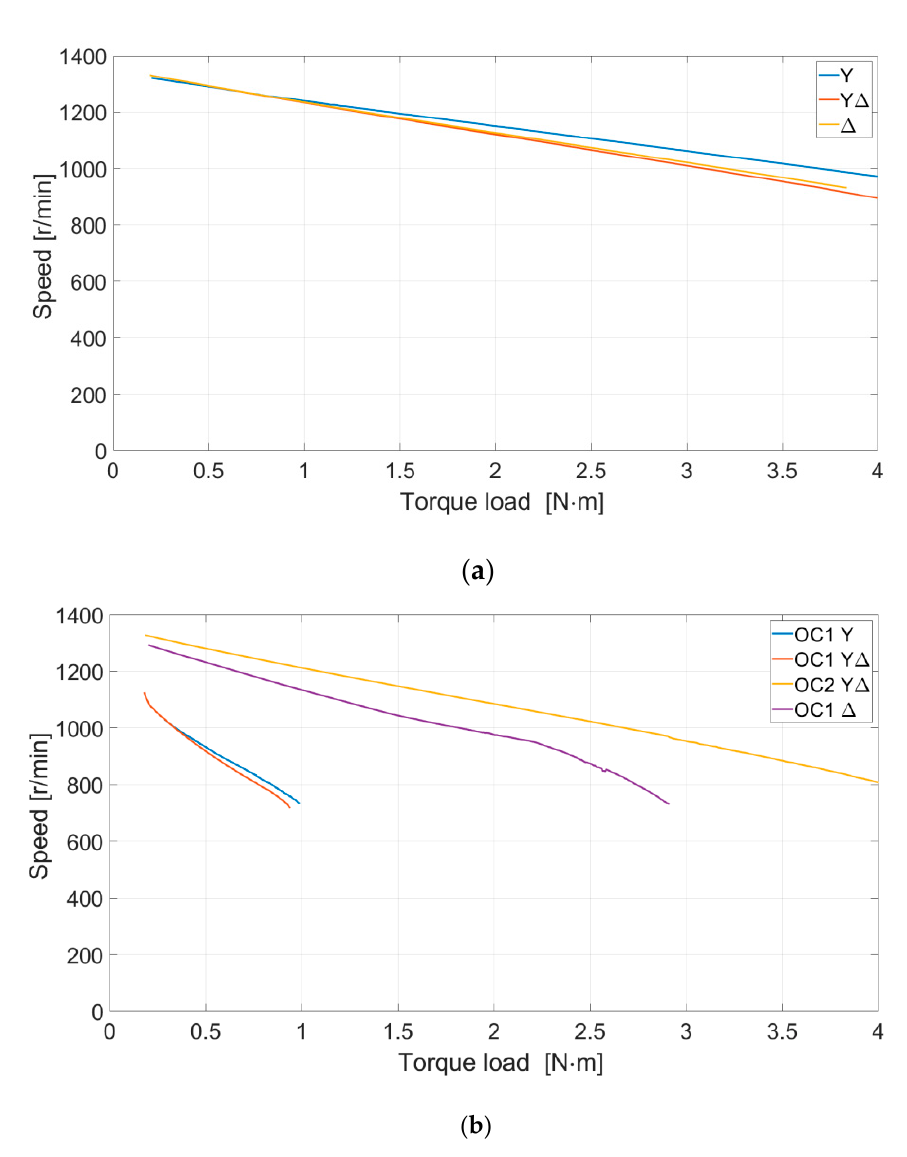
Figure 24. Speed vs. load torque for Y, Y Δ and Δ configurations: ( a ) healthy mode; ( b ) OC fault state.